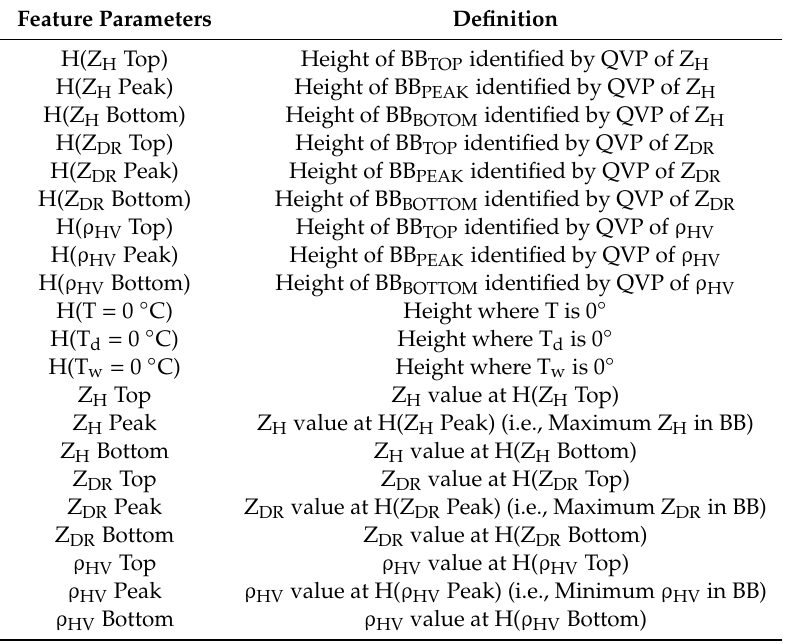
Table 2. Definitions of feature parameters for characterizing the